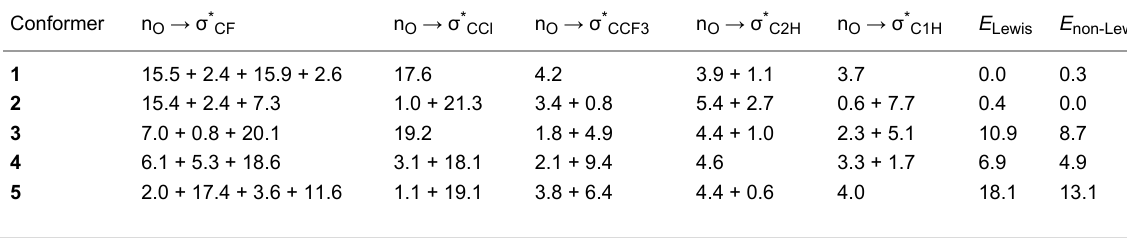
Table 3: Atomic properties (a.u.) obtained by QTAIM to characterize hydrogen bonds in isoflurane.